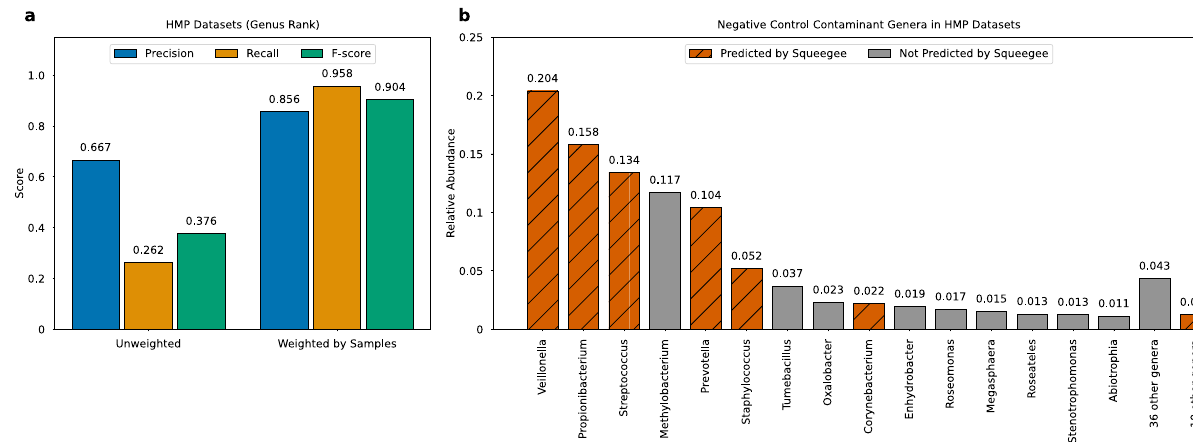
Fig. 4 | Squeegee performance on HMP metagenomic datasets. a Left panel depicts the Genus level precision, recall, and F -score using previously reported kit contaminants as the ground truth. Unweighted precision is calculated as the ratio betweenthe numberofpredicted contaminant taxa found inthe ground truthand thetotalnumberofpredictedcontaminanttaxa.Anunweightedrecalliscalculated as the ratio between the number of predicted contaminant taxa found in the